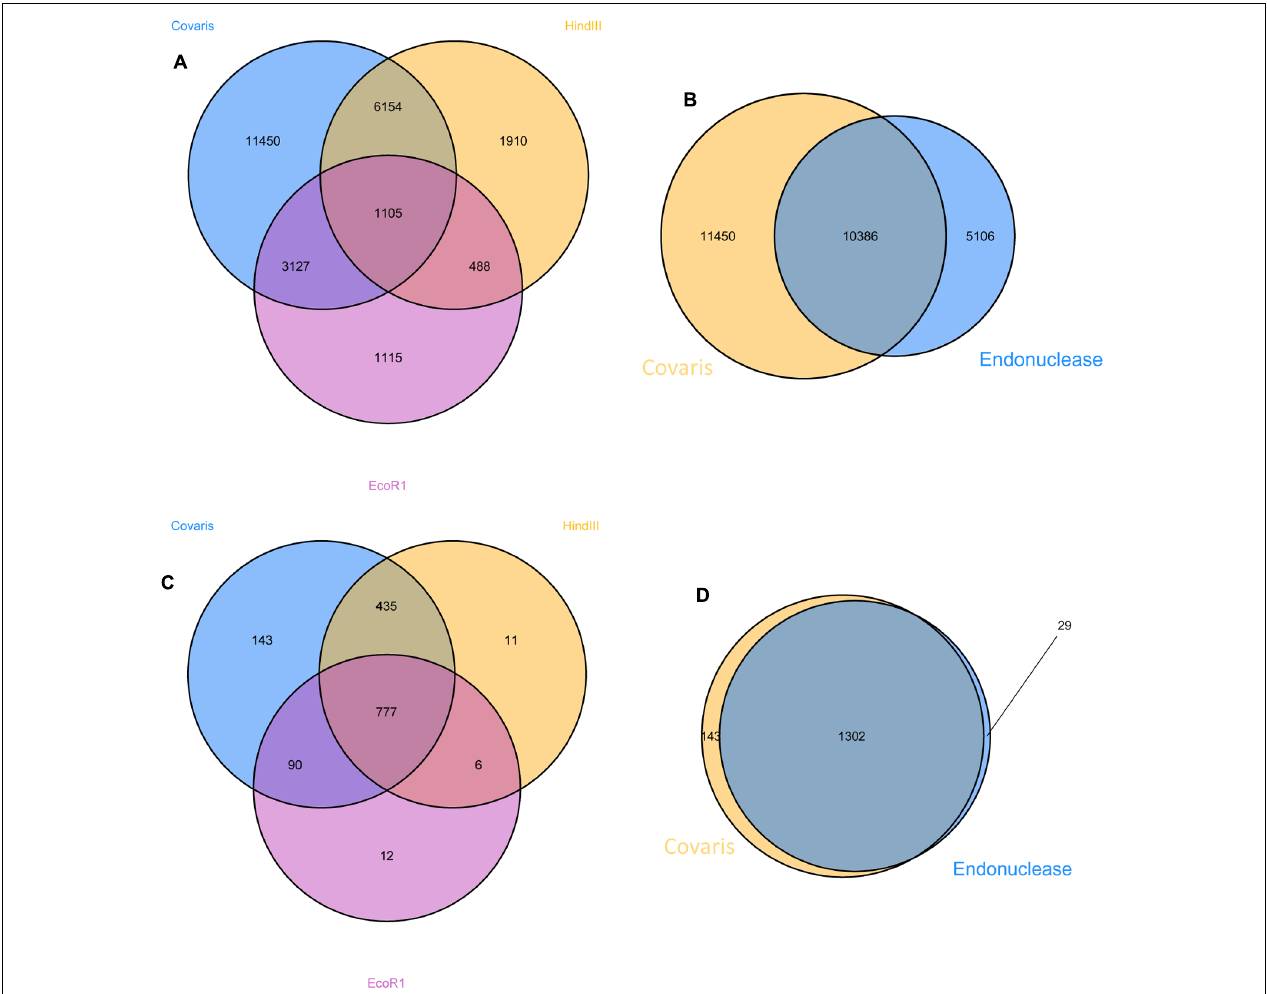
FIGURE 3 | Comparison of mutations detected in samples prepared by endonuclease digestion and random acoustic fragmentation (Covaris). Venn diagrams to demonstrate the overlap of mapped sequences detected from sample prepared using different procedures; (A) indicates the number of unique insertions using each procedure; (B) indicates the number of unique insertions using both endonuclease generated preparations compared to that generated by random acoustic shearing (Covaris); (C,D) as (A,B) , respectively, using mutated coding sequence as the unit of